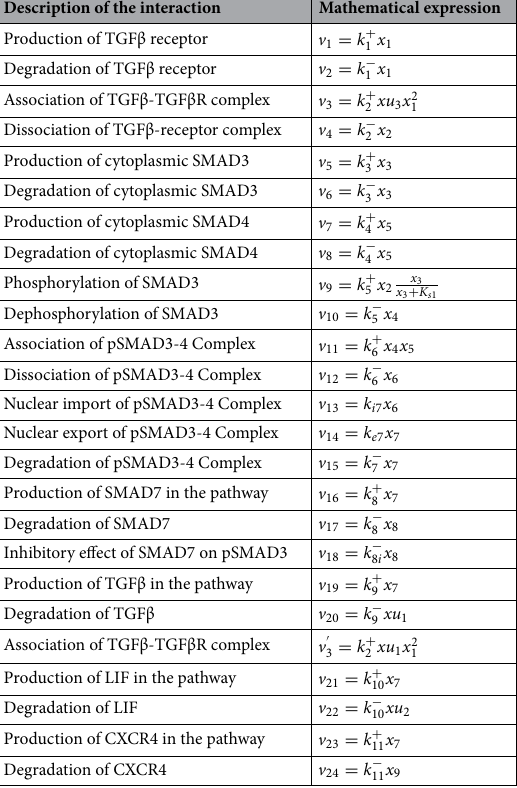
Table 1. Biochemical reactions and their mathematical representations in cancer cell